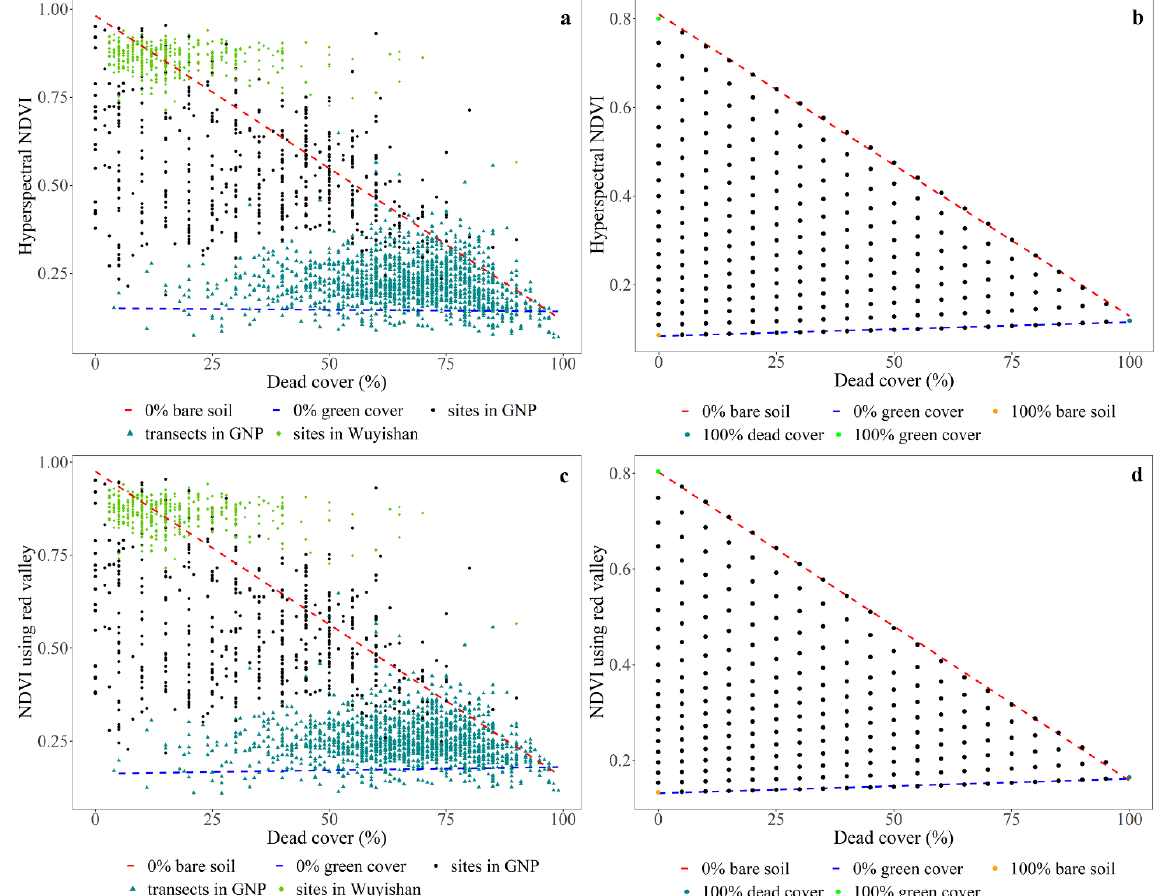
Figure 5. The relationship between NDVI and dead cover (“sites in GNP”, “transects in GNP” and “sites in Wuyishan” refer to the quadrat data collected in the sample sites in Grassland national park (GNP), in the transects in GNP, and in the sample sites in Wuyishan National Park (WNP), respectively; the red dash line refer to the linear relationship in the situation when the coverage of bare soil equals to 0%; the blue dash line means the relationship in the situation when green cover equals to 0%): ( a ) The relationship between field measured hyperspectral NDVI and dead cover; ( b ) the relationship between simulated hyperspectral NDVI and dead cover; ( c ) the relationship between field measured NDVI using red valley and dead cover; ( d ) the relationship between simulated NDVI using red valley and dead cover.